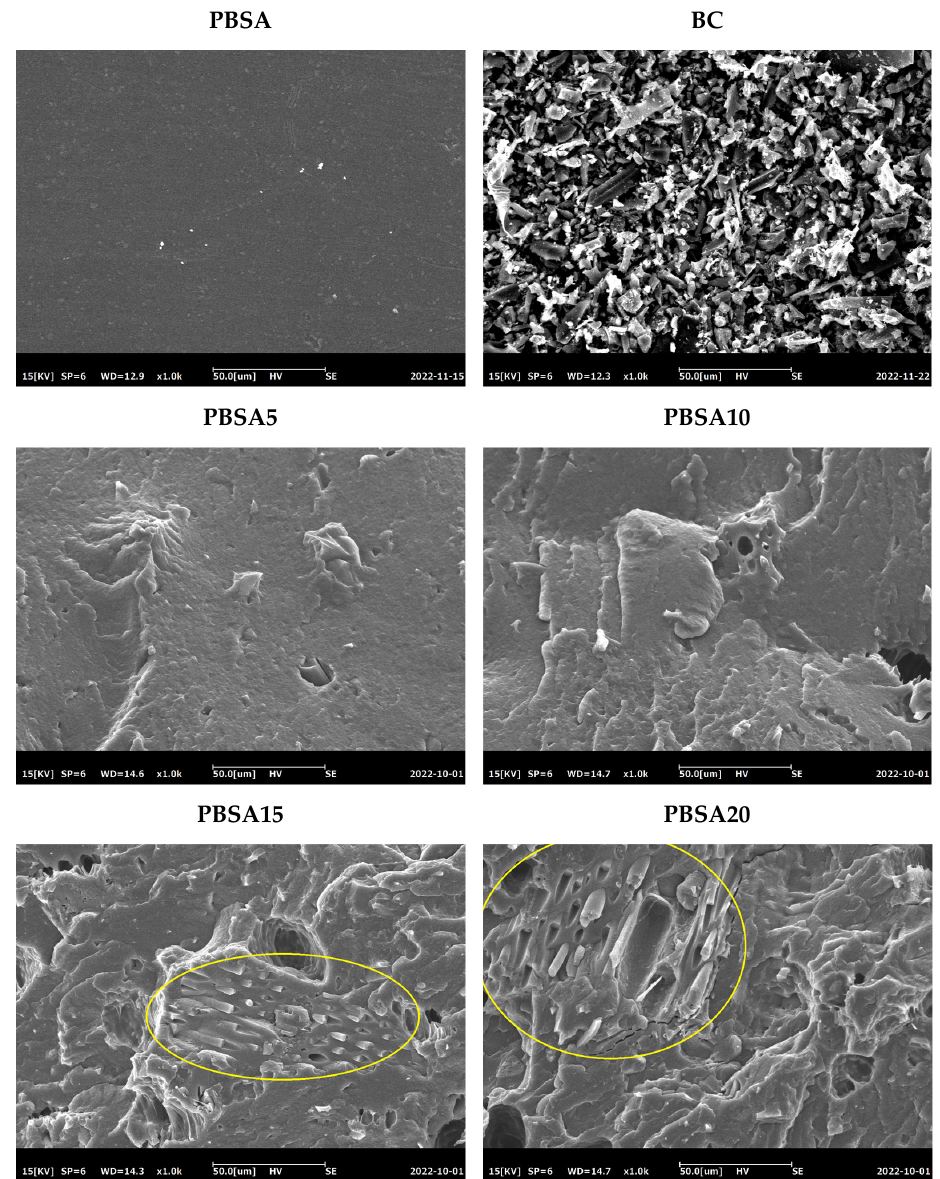
Figure 9. SEM images of PBSA, BC, and PBSA/BC pellets. Oriented particle streaks are highlighted in circle.